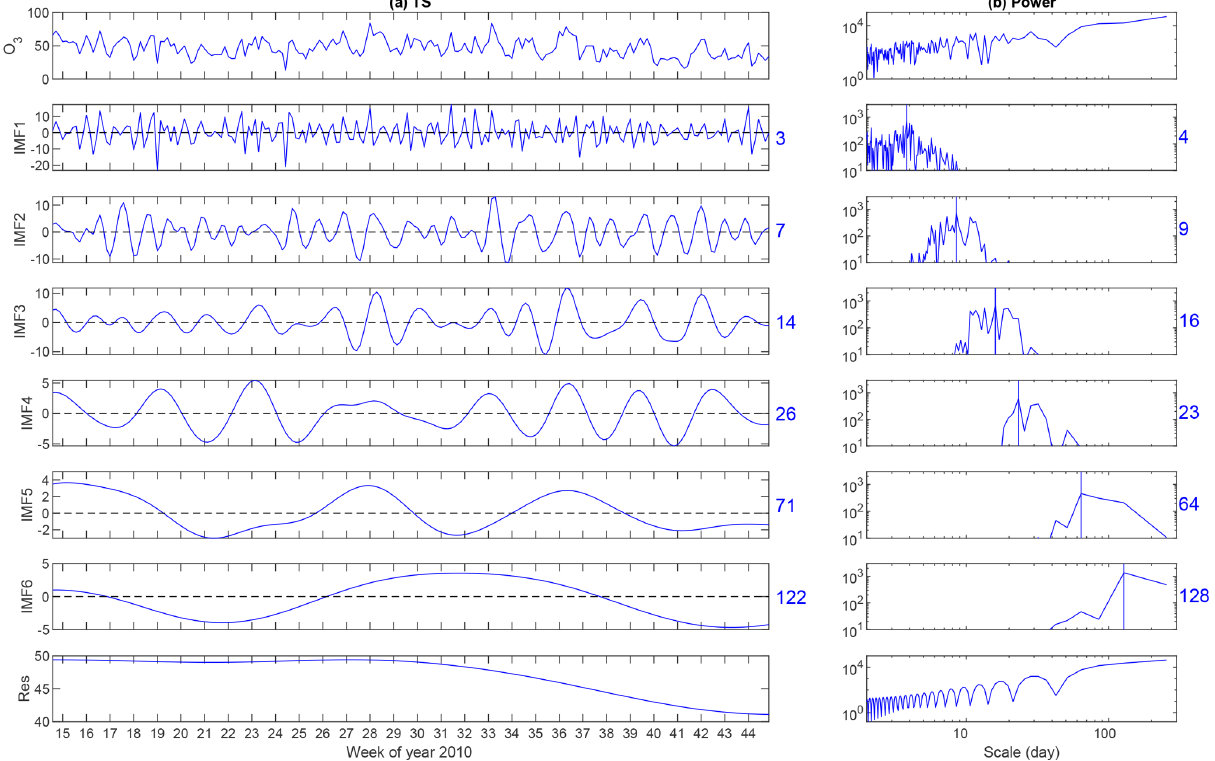
Figure 1. Results of the application of the Improved CEEMDAN technique (a modified version of EMD), which is designed for analyzing non-stationary and non-linear time series (TS) data to the daily maximum 8h ozone time series data at the Altoona, PA, site. The numbers on the right side represent the timescale (in days) associated with each IMF. Note that the power spectrum of raw ozone time series (upper right panel) shows that the energy in the 1–10d (synoptic) timescale is an order of magnitude less than that in the longer (baseline)